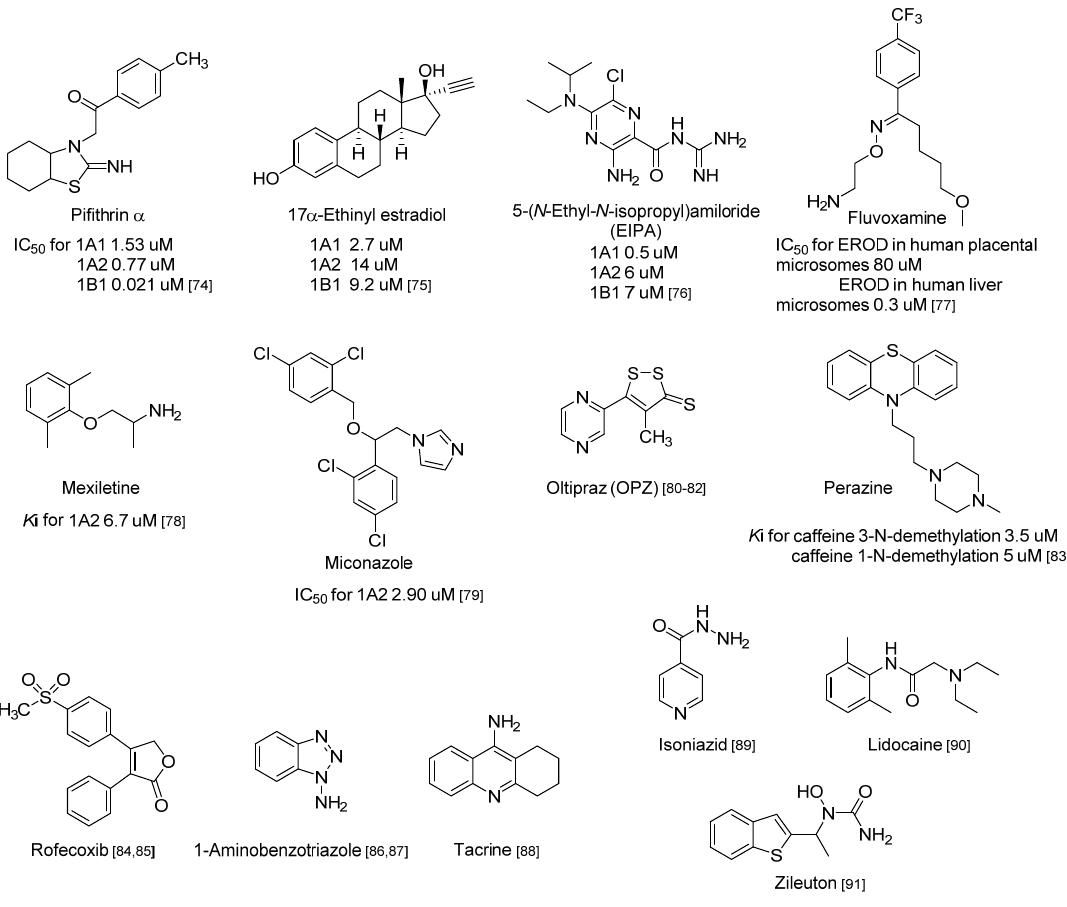
Figure 8. Drugs as P450 family 1